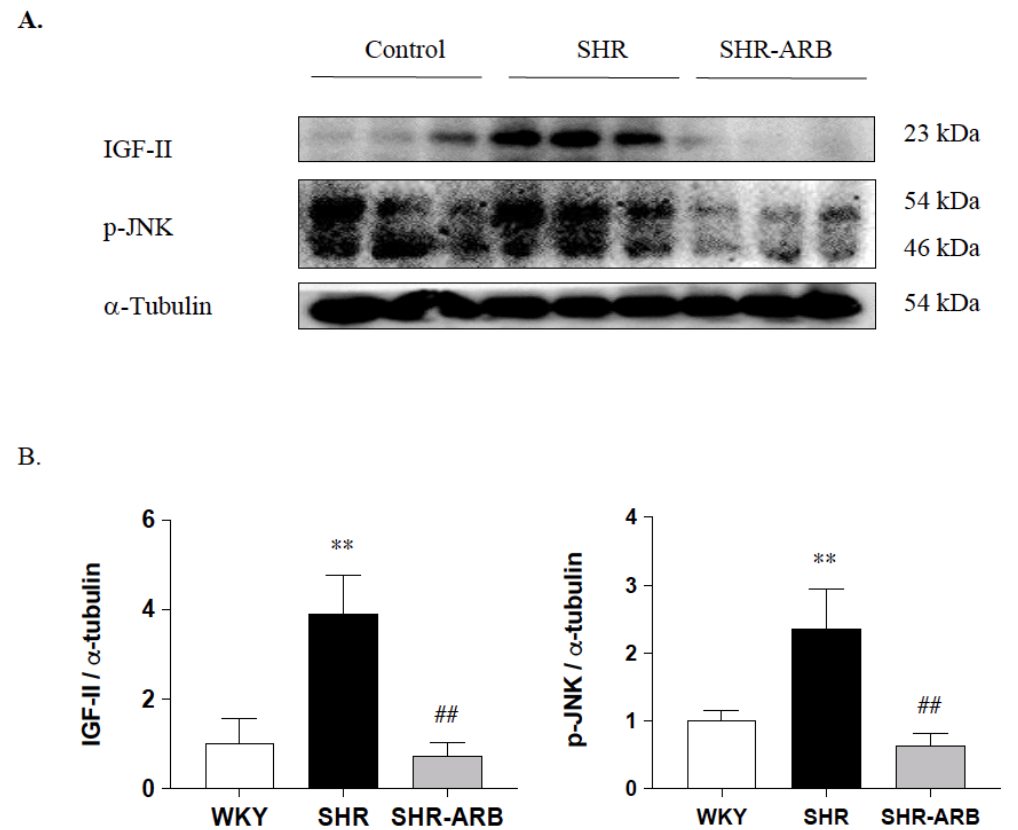
Figure 4. ( A ) The representative protein levels of IGF-II and p -JNK from the left ventricles in the normotensive group (WKY), untreated hypertensive group (SHR), and SHR rats with treated irbesartan (SHR-ARB), as measured by Western blot methods. The α -Tubulin served as an internal control. ( B ) Bars indicate the relative fold changes of protein levels relative to the Control group in IGF-II and p -JNK on α -Tubulin and show mean ± standard deviation (n = 8;8;8). ** p < 0.01: significant differences from the Control group. ## p < 0.01 indicates significant differences between the SHR group and the SHR-ARB group.